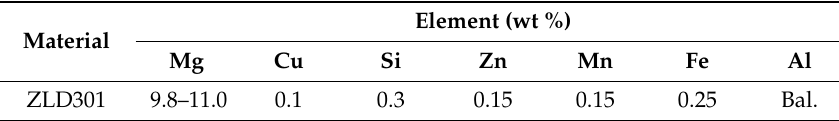
Table 3. Chemical composition of the ZLD301 aluminum alloy.